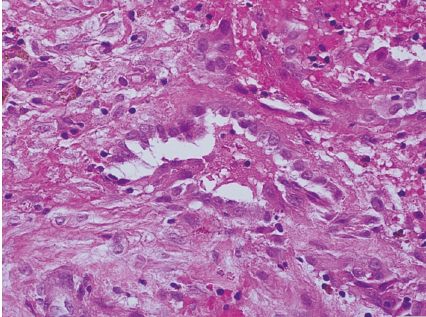
Figure 2: Epithelioid cells forming a structure reminiscent of glandular space.